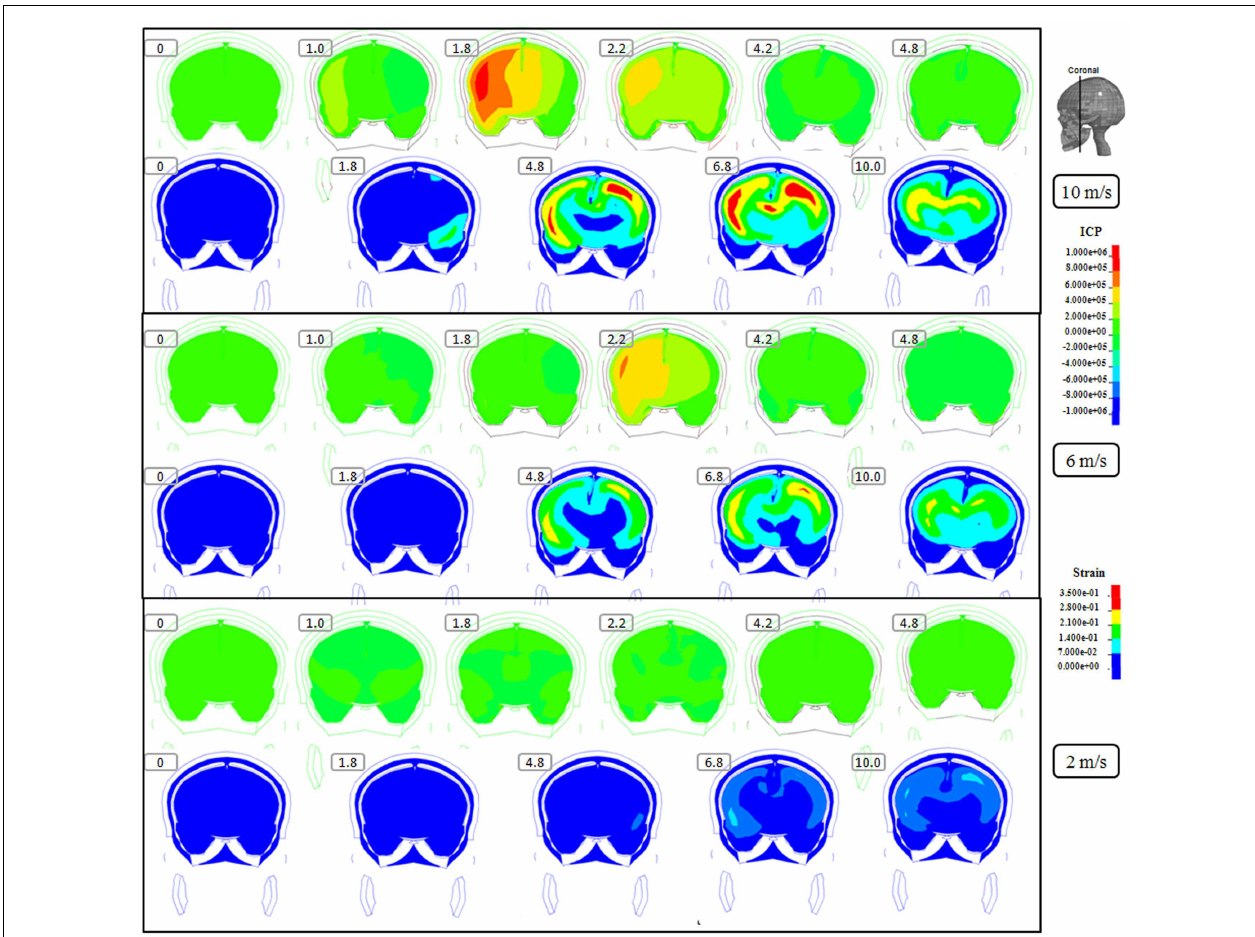
The location of the coronal slice is indicated in the figure.The numbers included in the figure represent the time after the impact with unit of millisecond.